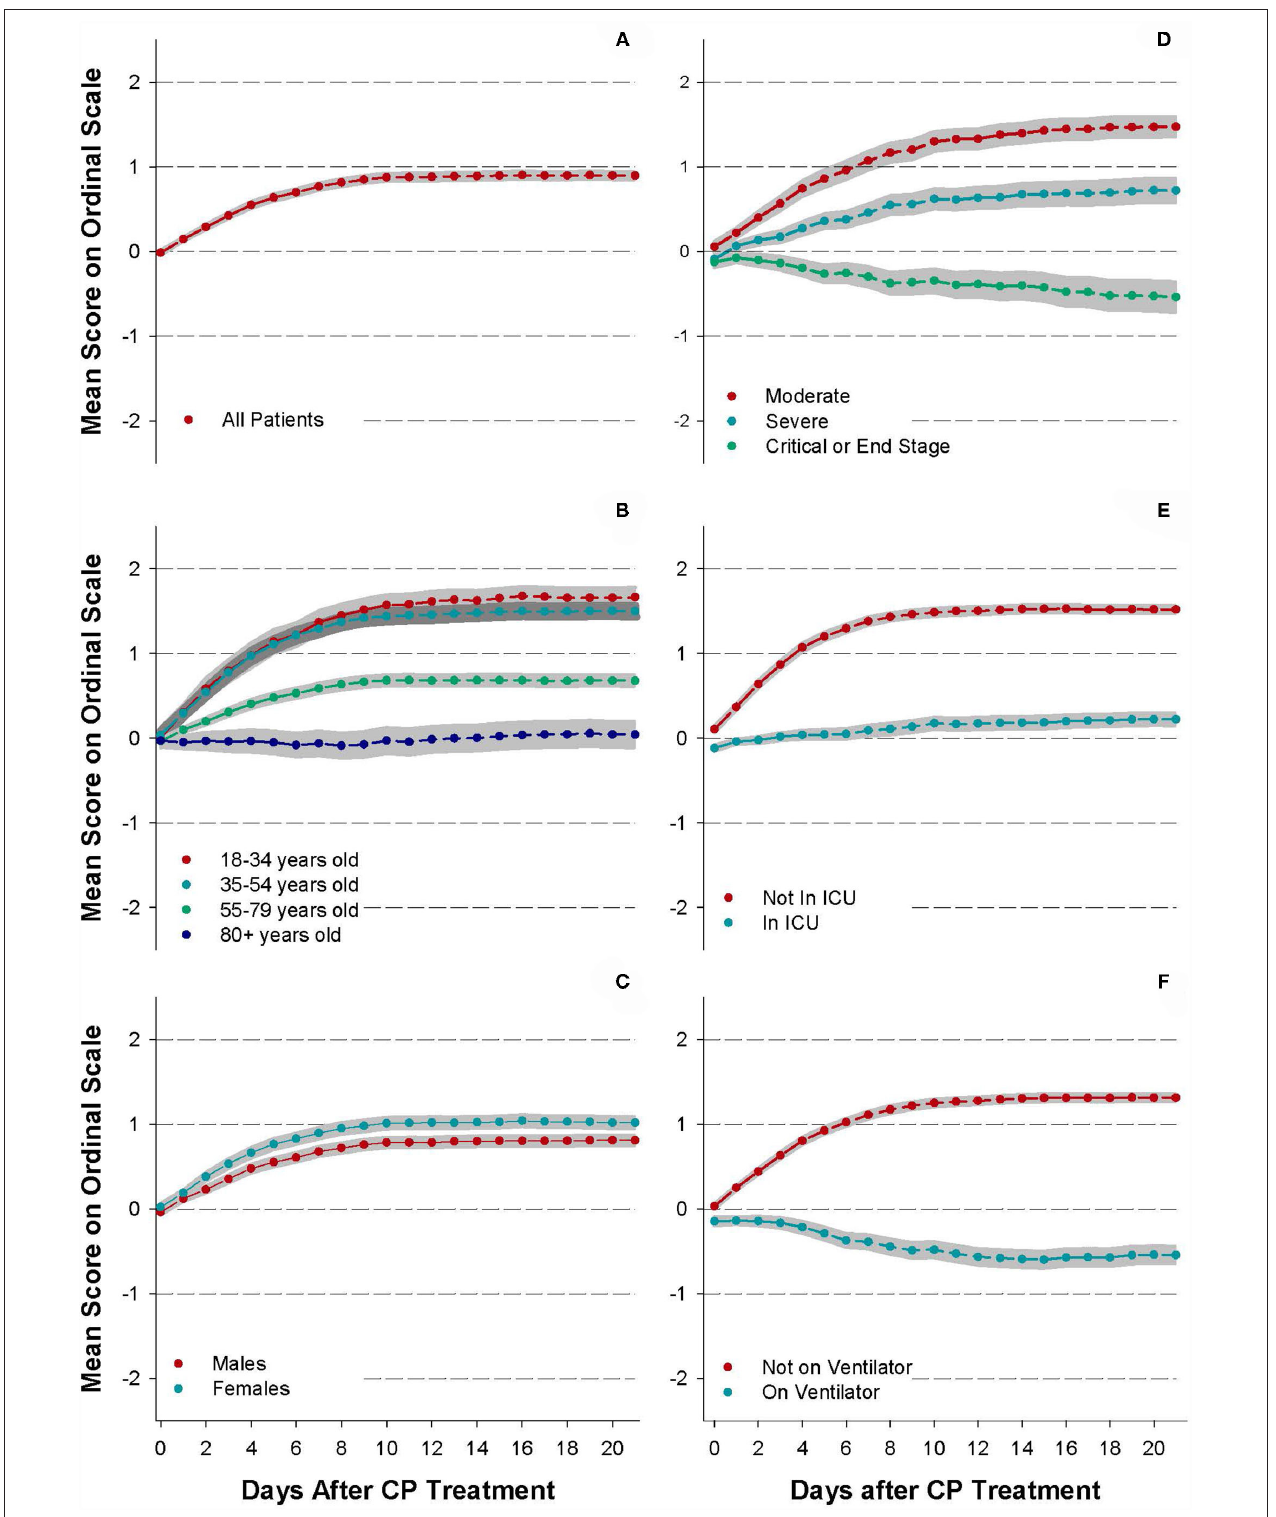
FIGURE 1 | Trajectories of daily status improvement/worsening. Subgroup analyses include (A) all patients, (B) by age, (C) by sex, (D) by initial clinical status, (E) by ICU status prior to transfusion, and (F) by ventilator status prior to transfusion. Net patient scores of 0 = no net change, + 1 = net improvement but still hospitalized, − 1 = net worsened and still hospitalized, + 2 = discharged from hospital, and − 2 = patient expiration. Points are the mean score for each day, and gray bands indicate the 95% confidence interval for each data set.